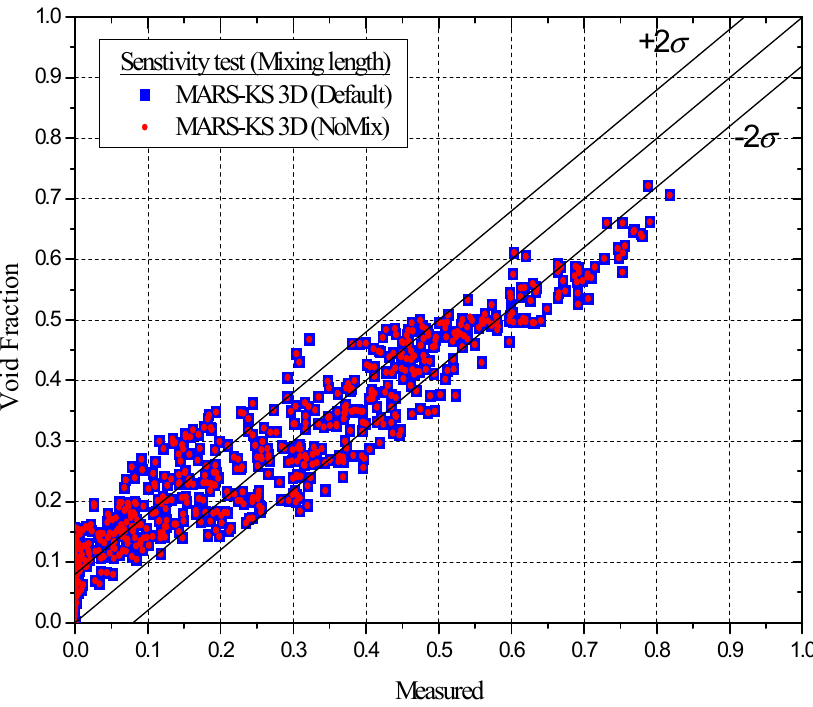
Figure 6. Model comparison of MARS-KS for sensitivity check to mixing length . Table 2. Results of one-sample t -test for assessing model predictions of MARS-KS.